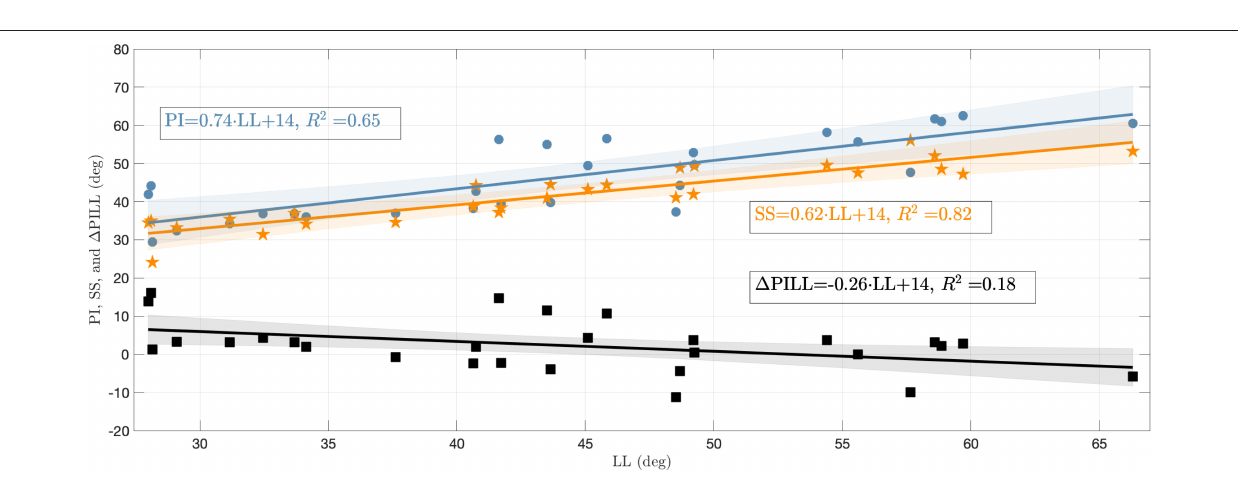
FIGURE 3 | PI, SS, and 1 PILL plotted against LL. The blue circles represent the PI, orange asterisks the SS, and black squares the 1 PILL for the 28 individual lumbar spines. Regressions lines (with confidence bands) are displayed in corresponding colors and their equations as well as coefficients of determination ( R 2 ) are stated in the